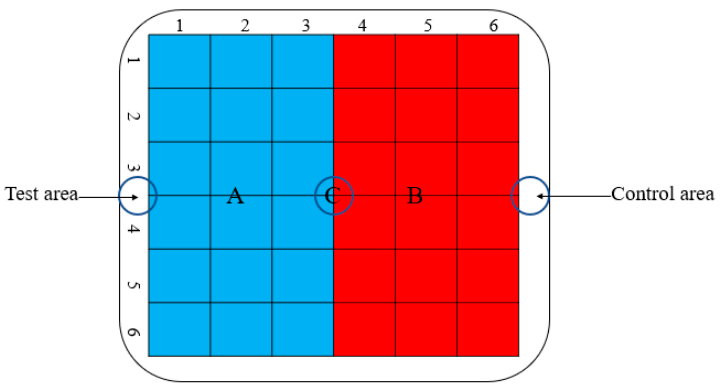
Figure 8. Schematic diagram of the chemotaxis test in square Petri dishes. A: test area; B: control area; Blue represents area A; Red represents area B.